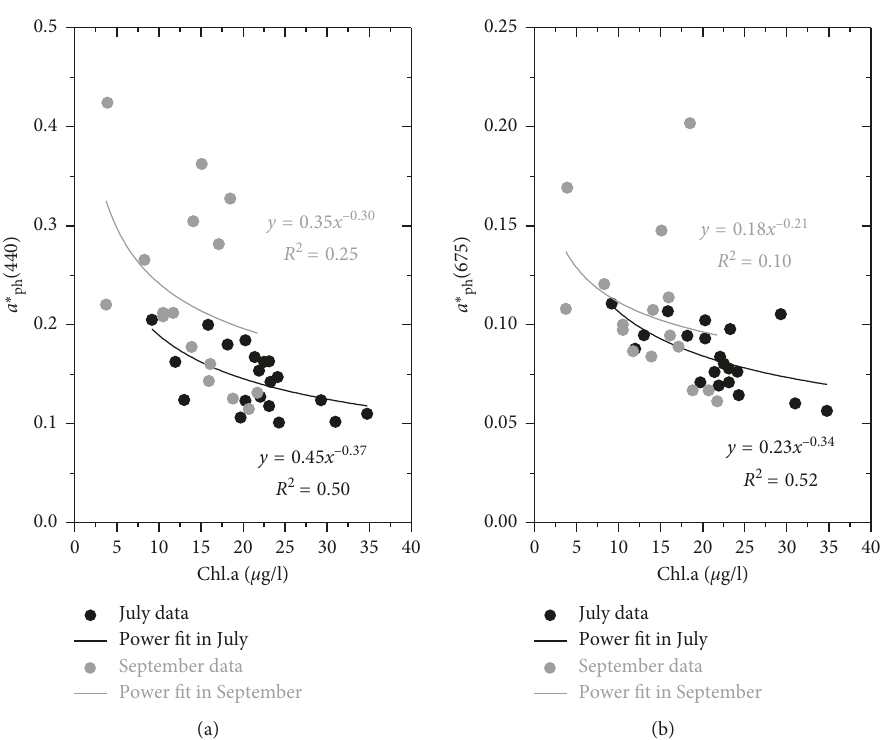
Figure 8: The power functions of a